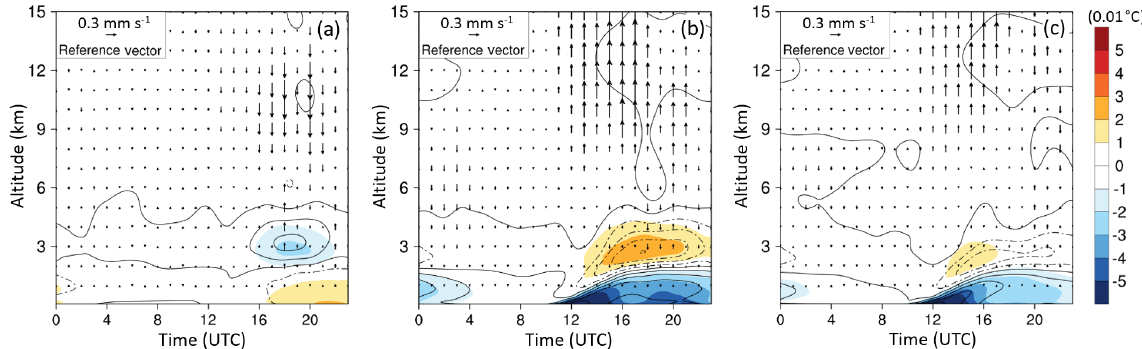
Figure 7. Domain-averaged difference in air temperature (shaded, in intervals of 0.01 ◦ C), relative humidity (contour lines, in intervals of 0.1%), and updraft velocity (arrows) caused by BB aerosols’ (a) ACI, (b) ARI, and (c) total effect in the EMIS1 emission scenario.